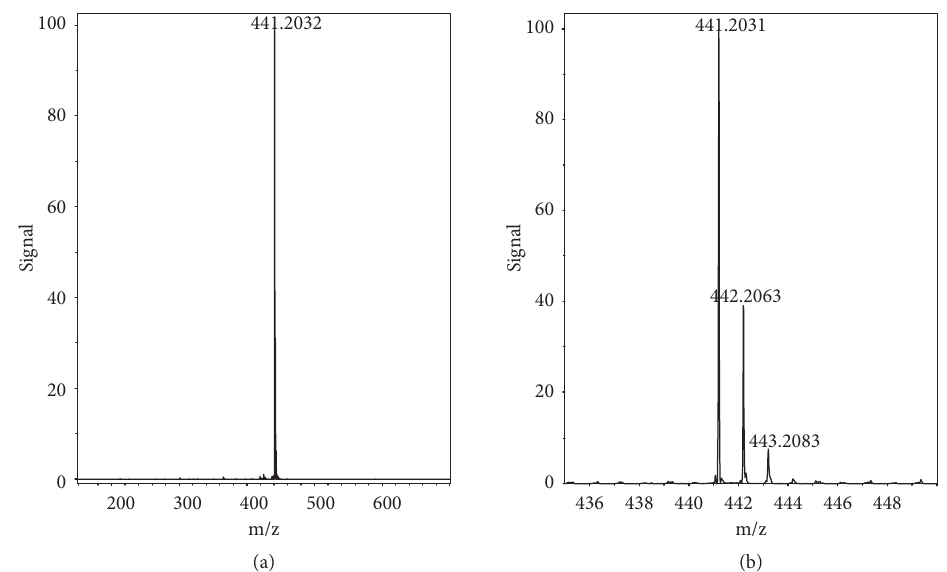
Figure 4: Positive-mode electrospray ionization mass spectrometry of ibrutinib at room temperature with a direct fusion of methanol solution using high-resolution mass spectrometry: (a) full-spectrum and (b) the isotopic